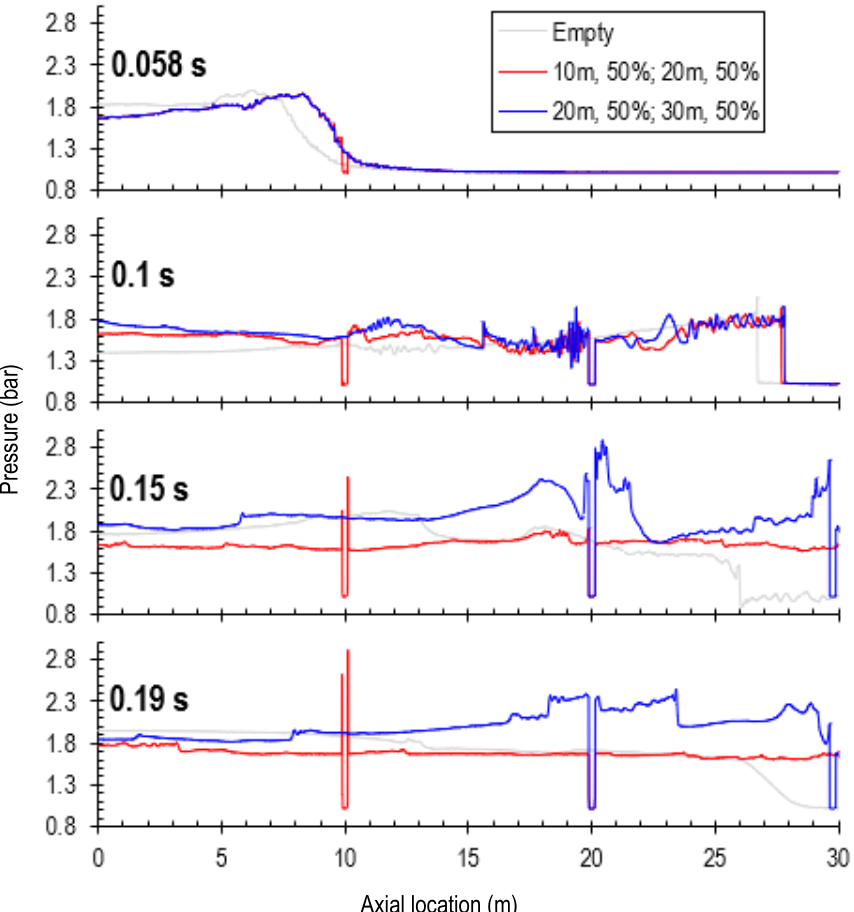
Figure 16. Evolution of pressure profiles along the tube centreline for different scenarios where two obstructions are installed at different locations (at 10 m and 20 m; and at 20 m and 30 m) with 50% inflation. The temperature profiles in the empty tube are also included for reference.